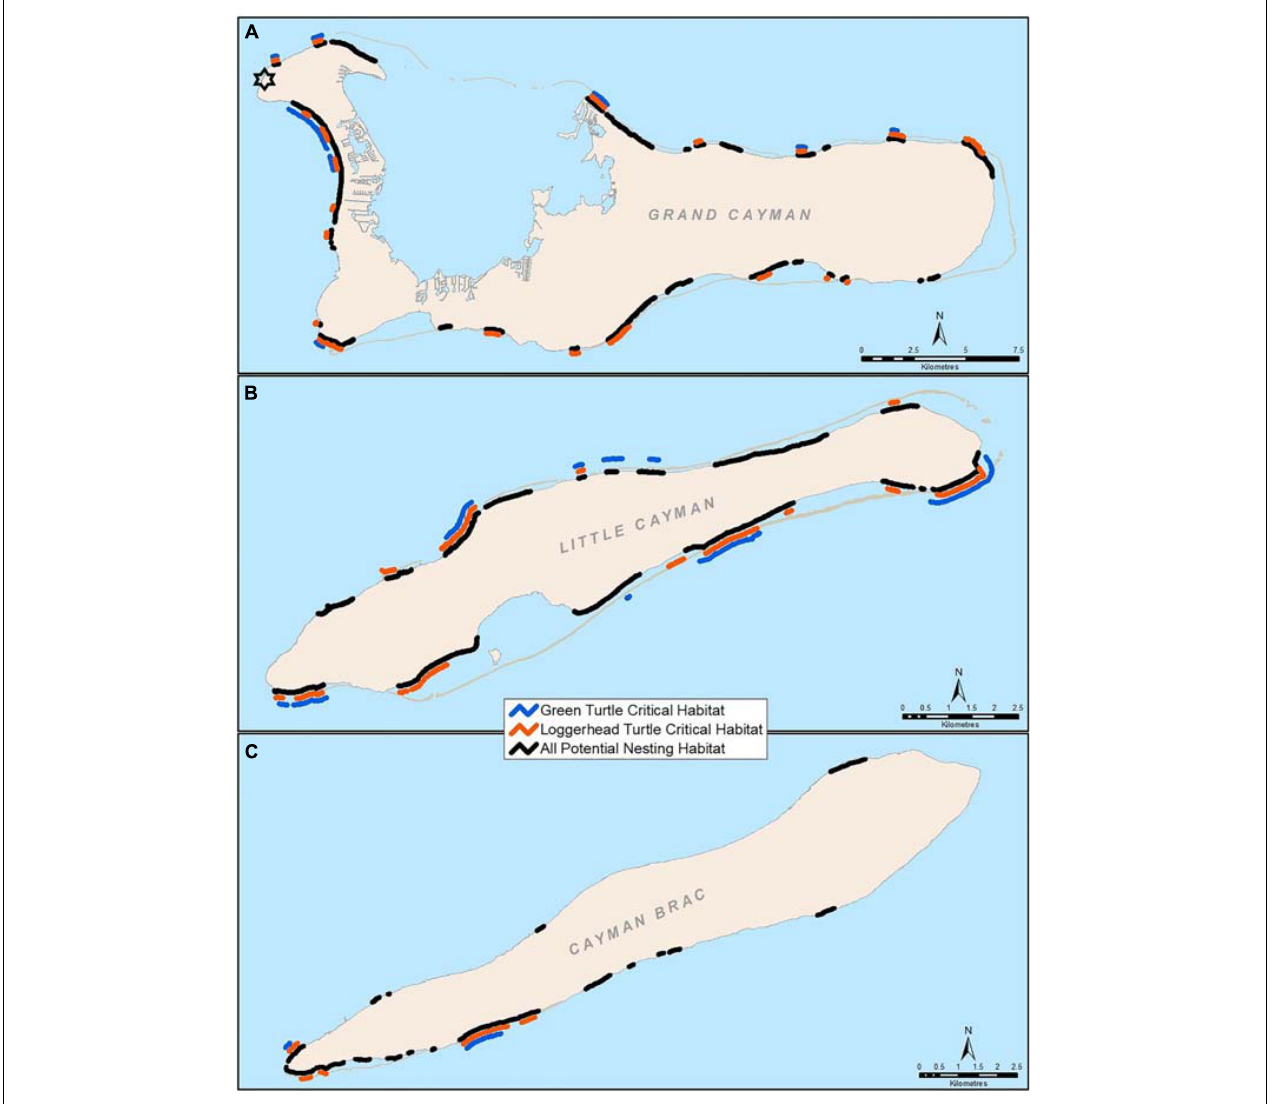
FIGURE 4 | Critical habitat for green and loggerhead turtles in Grand Cayman (A) , and Little Cayman (B) and Cayman Brac (C) . The location of the Cayman Turtle Farm in Grand Cayman is noted by the